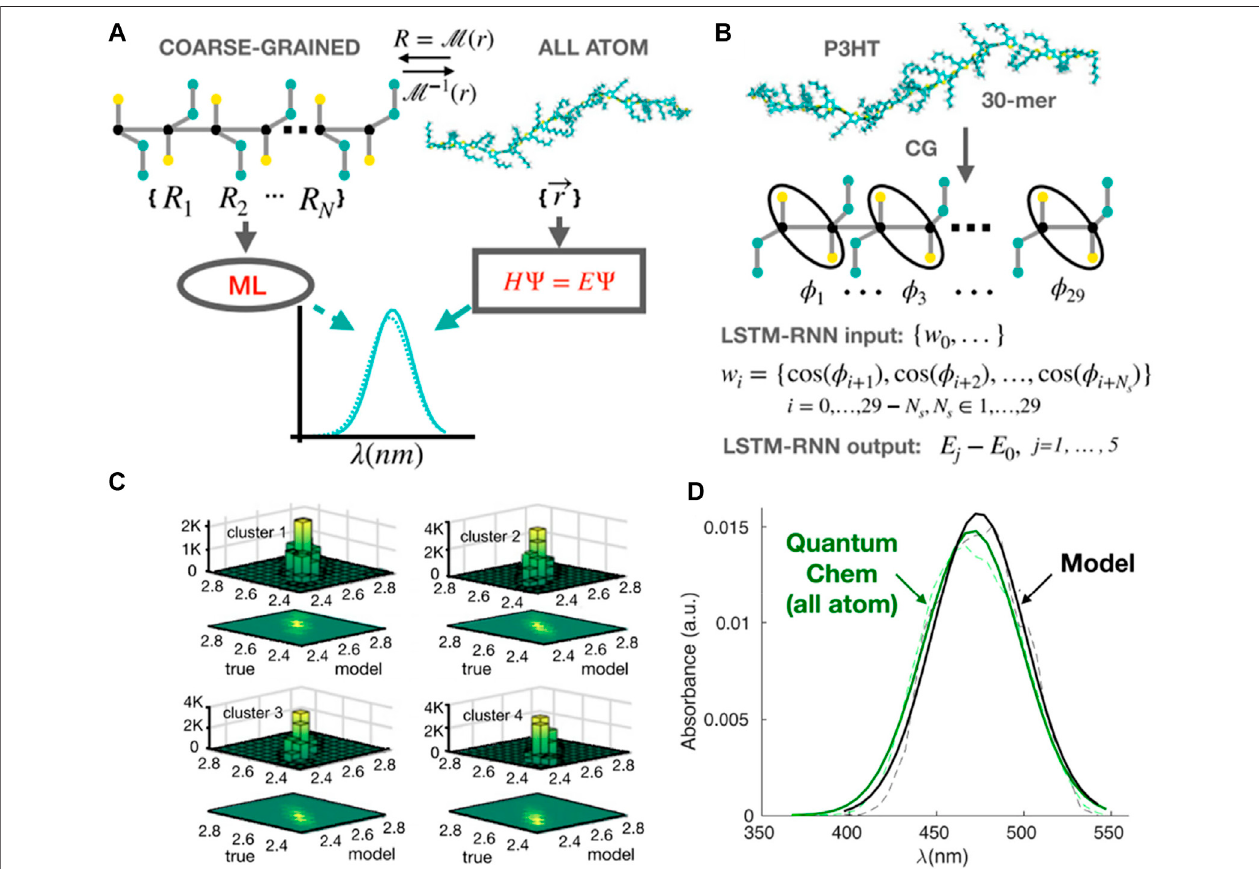
FIGURE 7 | Predicting optical spectra for polymers using CG models coupling RNNs. (A) Scheme of ML method to predict spectra from CG representations of conjugated polymers, compared to the traditional approach using all-atom quantum calculation. (B) CG representations are back-mapped in order to obtain inter- monomer dihedral ( φ ) information. The sequence of cos φ along the backbone of the polymer is used as input of an LSTM-RNN model to predict the values of excited- state energies, then compared to all-atom quantum calculations. (C) Predictions of energies for the ground-to- fi rst excited S 1 state transition (E 01 ) are validated in four distinct clusters (four distinct torsional subsets in the dataset) with the Pearson coef fi cient is ∼ 0.94 for all clusters (i.e., highly accurate prediction). (D) A comparison of spectra obtained using quantum chemistry from atomistic representations (green) and the LSTM-RNN model using inter-monomer dihedrals information (black): dashed line for raw statistical data and solid line after using Gaussian fi ts. Figure was reproduced from Ref. (Simine et al., 2020) with permission.